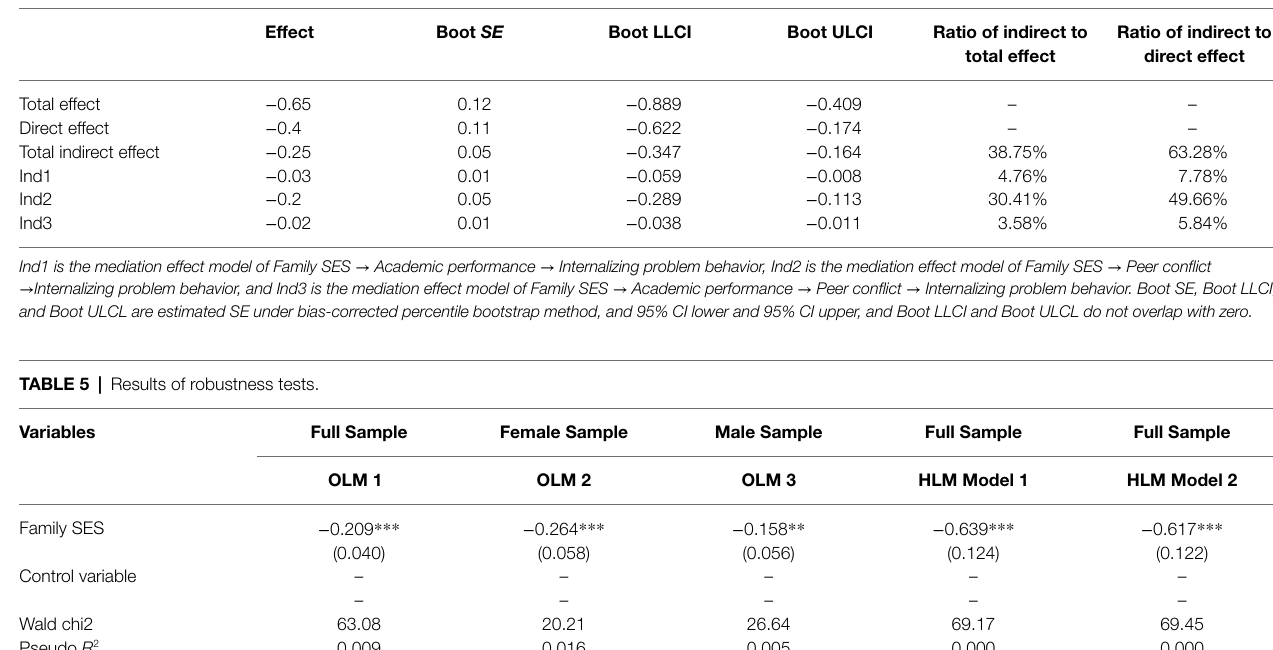
TABLE 4 | Results and comparison of chain mediating effect ( n = 2,467).